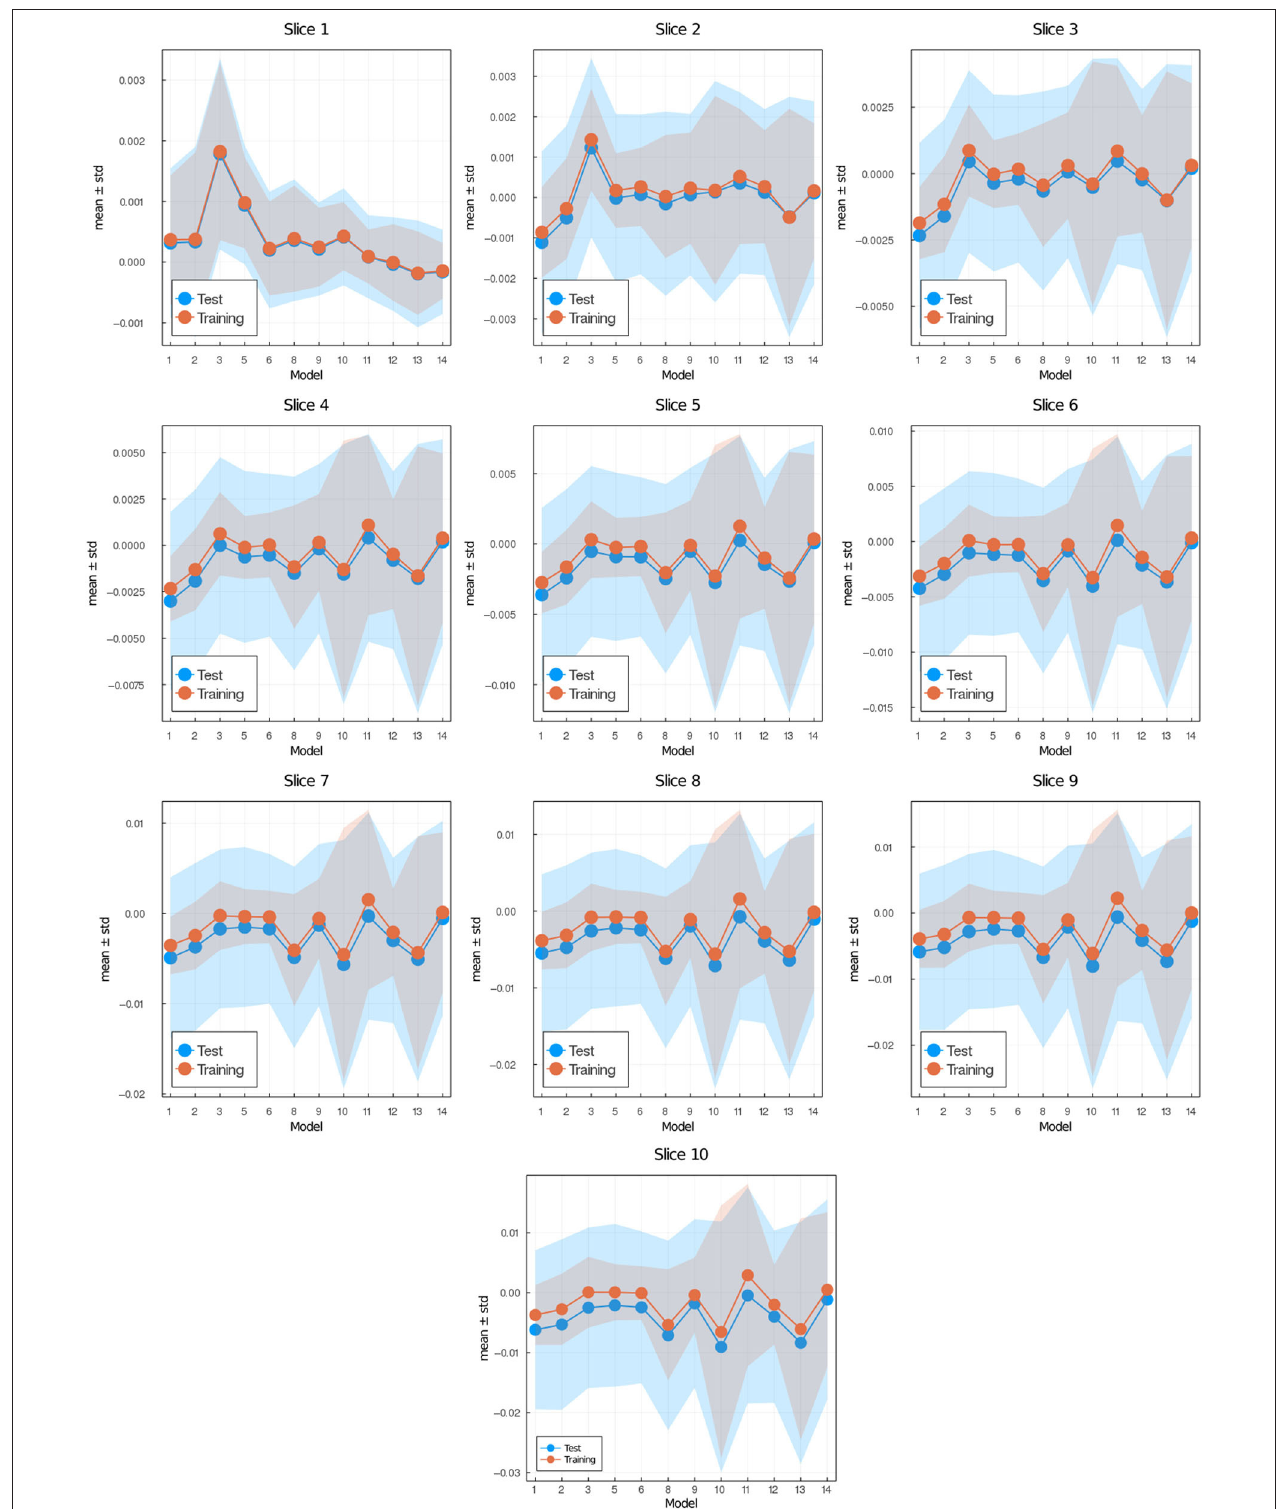
FIGURE 9 | Mean (data points) values in the interval [0.1